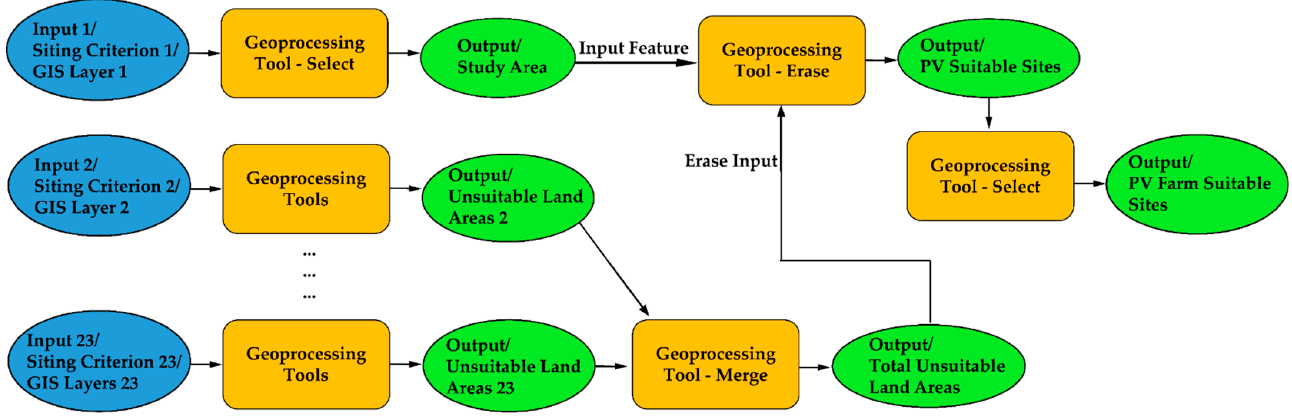
Figure 2. The form of the linear geoprocessing siting model deployed in GIS for the PV siting analysis.